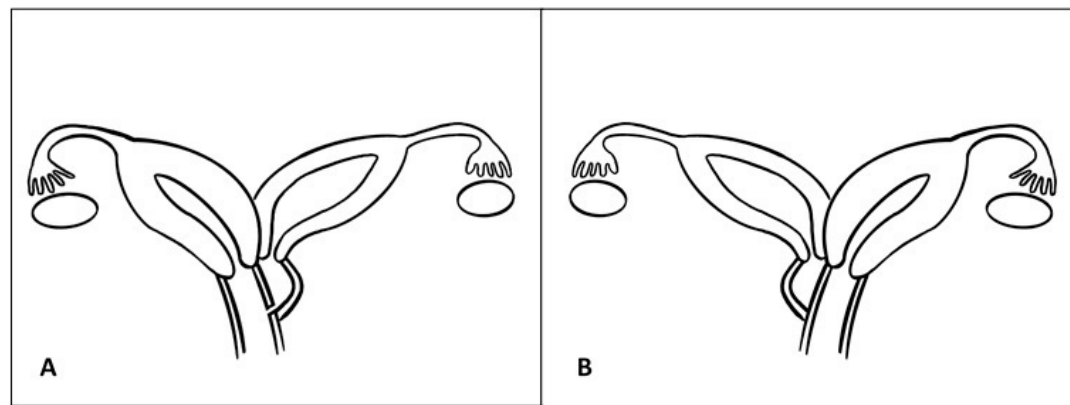
Figure 2. Classification of Herlyn-Werner-Wunderlich Syndrome (HWWS), based on Zhu et al. [11]. According to this classification, the 17-year-old patient should be qualified as sub-class 2.1, and the 13-year-old as 1.1 (Figure 3).